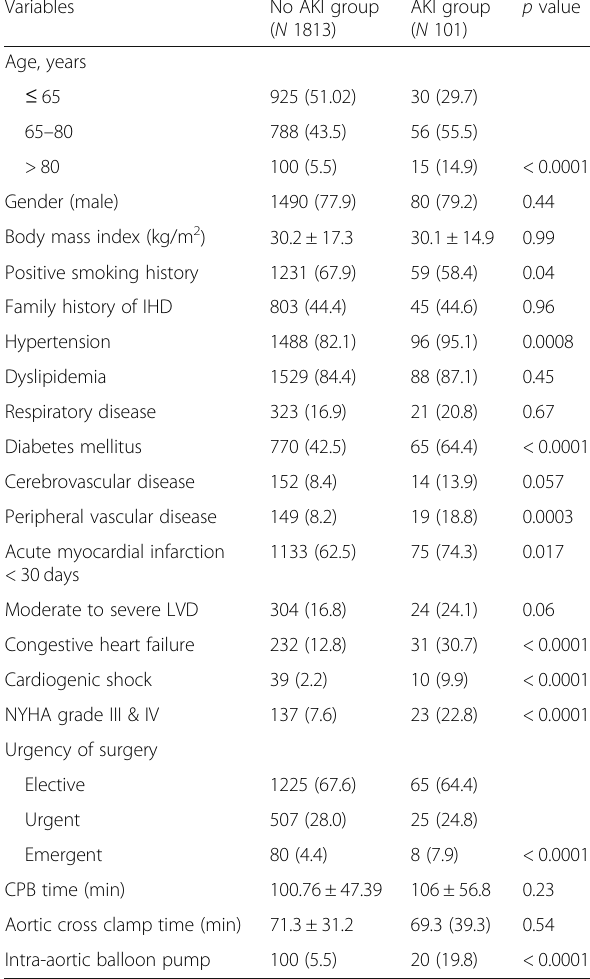
Table 1 Comparisons of demographic and clinical variables in patients with and without postoperative AKI in isolated CABG cohort